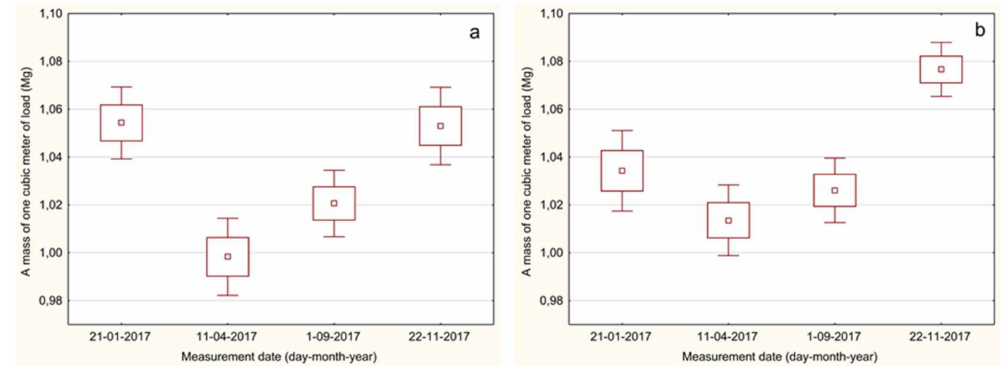
Figure 4. Comparison of average load weight values by measurement date for a unit with a semi-trailer ( a ) and a trailer ( b ).